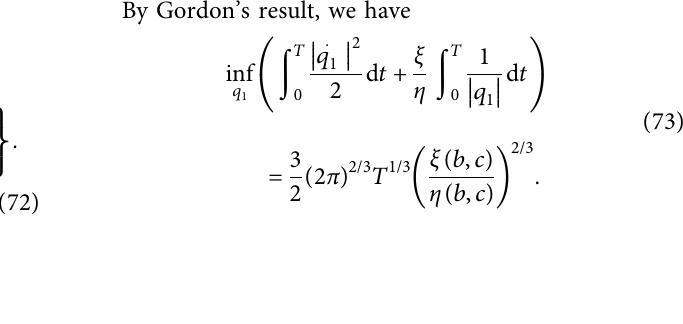
� m � m ≠ m ≠ m 1 3 0 2